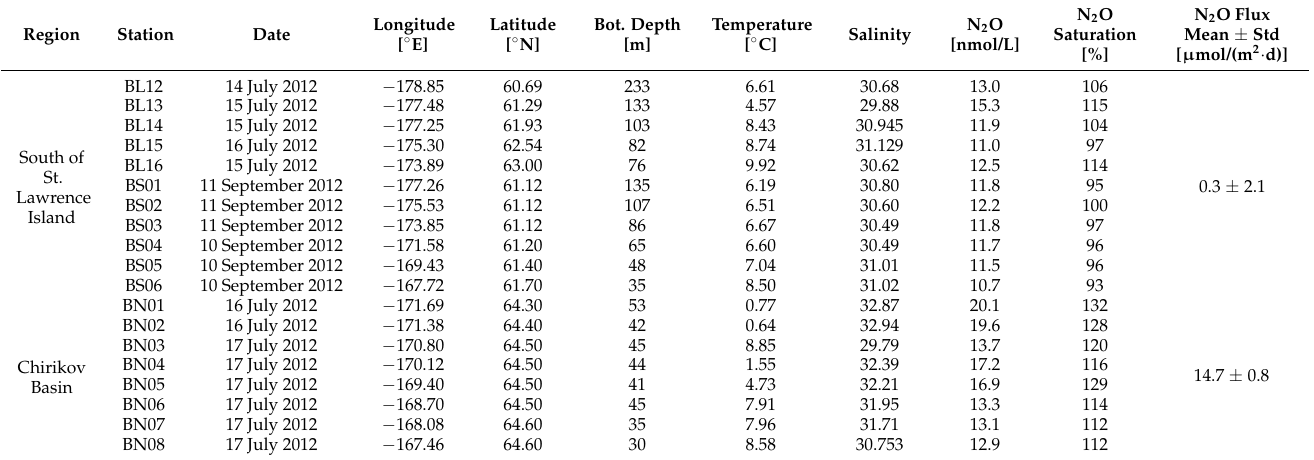
The sampling information and surface concentration, saturation and flux during CHINARE2012 in the Northeastern Bering Sea